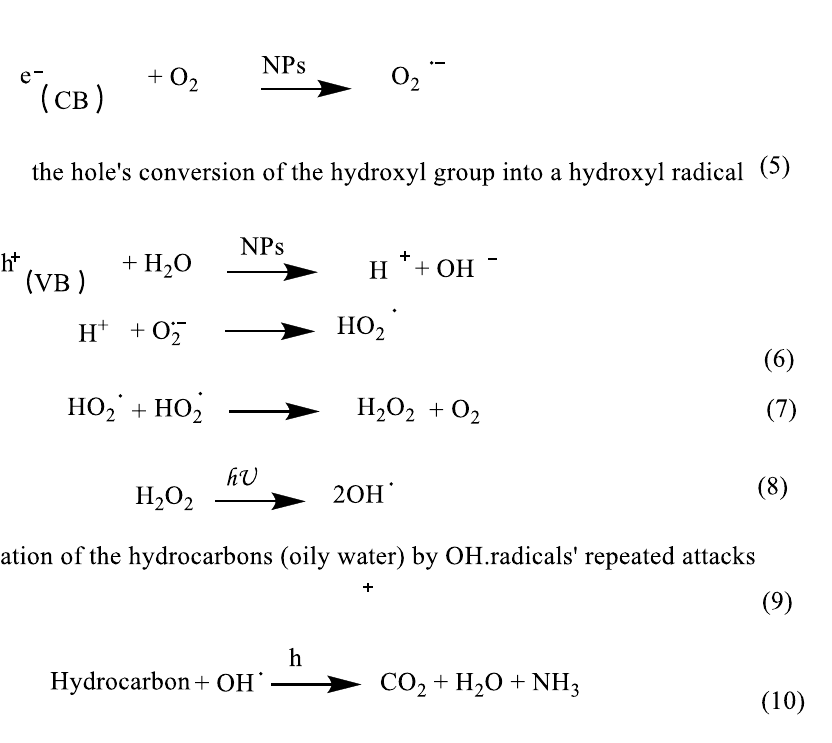
Figure 9. illustrates the predicted reaction process for the photocatalytic breakdown of the pollutant’s hydrocarbon.